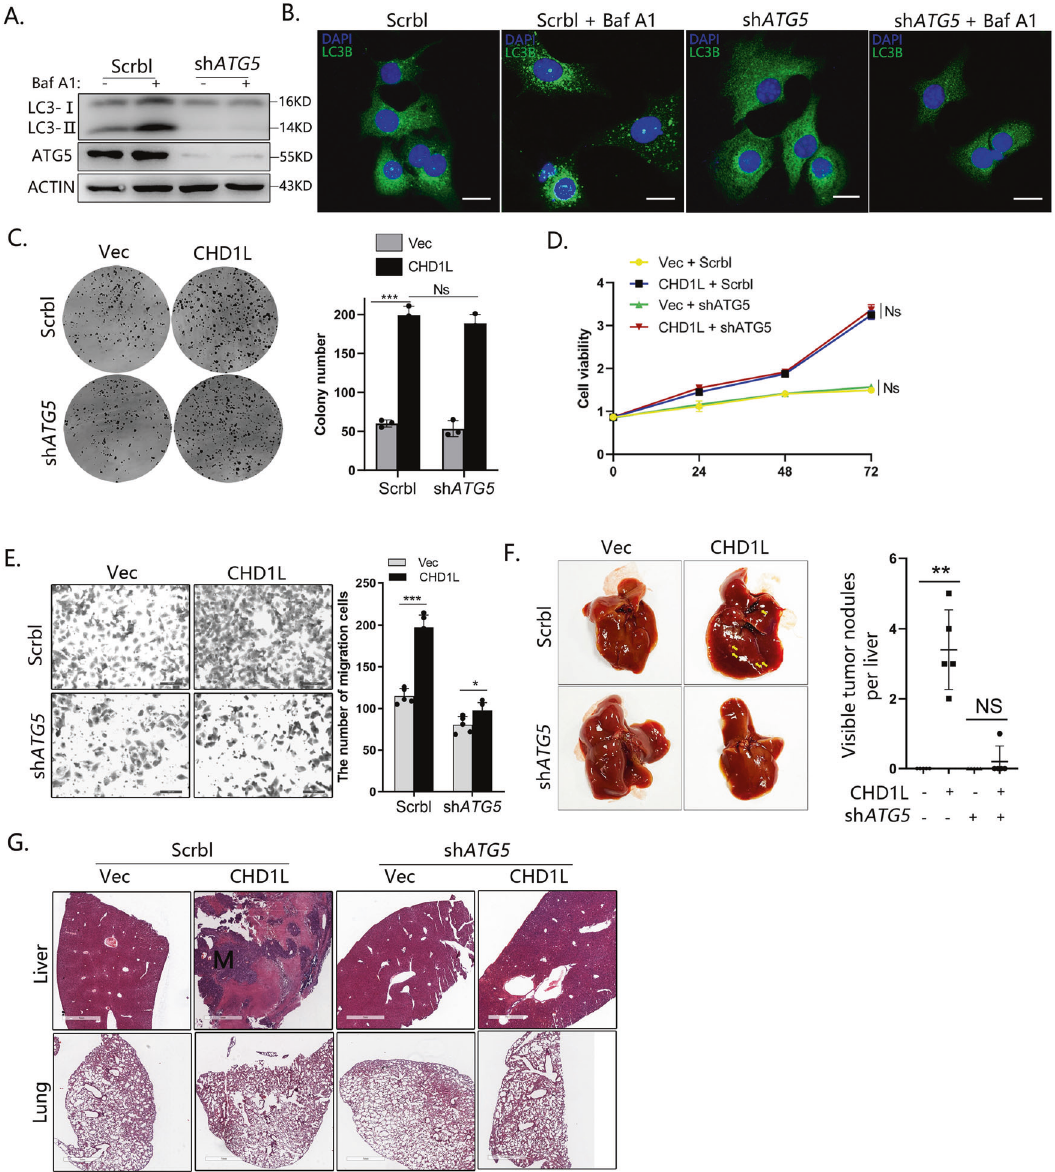
Fig. 1 Blocking autophagy in HCC cells impair the role of CHD1L to cell metastasis but not cell growth. A Western blot for ATG5 in Scrbl shRNA and ATG5 shRNA-expressing QGY-7703 clones in the presence or absence of 80 nM bafA1 (6 h). B Immuno fl uorescence for endogenous LC3B. C Crystal violet staining assays of Scrbl shRNA and ATG5 shRNA-expressing QGY-7703 clones in the indicated group for 2 weeks. D Cell growth in complete medium over 72 h. Mean ± SD, n = 3. E Migration assay and related quanti fi cation for Scrbl shRNA and ATG5 shRNA- expressing QGY-7703 clones in Vector or forced CHD1L group. (*** p < 0.001, Ns no signi fi cant; Student ’ s t test; Mean ± SD, n = 5/group). F Representative overall picture of livers of mice with Scrbl shRNA and ATG5- shRNA in Vector or forced CHD1L tumors 6 weeks post-spleen injection. Mean number of livers metastases in mice with control or autophagy-de fi cient in Vector or forced CHD1L tumors at 6 weeks (** p < 0.01, Ns no signi fi cant; Student ’ s t test; Mean ± SD, n = 5/group). G Representative H&E-stained sections of lungs and livers of mice with Scrbl shRNA and ATG5- shRNA in Vector or forced CHD1L tumors 6-w post-spleen (Fig. 4E). To identify the peak binding region of CHD1L on mRNA and protein level. In contrast, overexpression of CHD1L ZKSCAN3, three pairs of primers covering different sites of the suppressed ZKSCAN3 expression both at mRNA and protein level. predicted regions were designed for ChIP-PCR assay. In accor- The expression of ZKSCAN3 was further detected by IF staining, dance with the ChIP-sequencing data, the peak binding site of and the results showed that weak or negative staining of CHD1L was con fi rmed be located at the 4692 – 4341 bp region ZKSCAN3 (red) was found in the nucleus of cells with strong upstream to TSS of ZKSCAN3 (Fig. 4E, F). Putative CHD1L-binding CHD1L signaling (green). Conversely, high expression of ZKSCAN3 fragments (fragment 1 ( − 4741 to − 4341 bp), fragment 2 ( − 4608 was found in CHD1L negative cells (Fig. 4D). These fi ndings to − 4341 bp), fragment 3 ( − 4518 to − 4341 bp), and fragment 4 indicated that the expression of ZKSCAN3 was negatively (-4428 to -4341bp)) were constructed in pGL3 vectors, and correlated with CHD1L. The CHD1L-binding region displayed by transiently transfected into QGY-7703 cells in indicated CHIP-seq is from 4741 to 4341 bp upstream to the TSS of ZKSCAN3